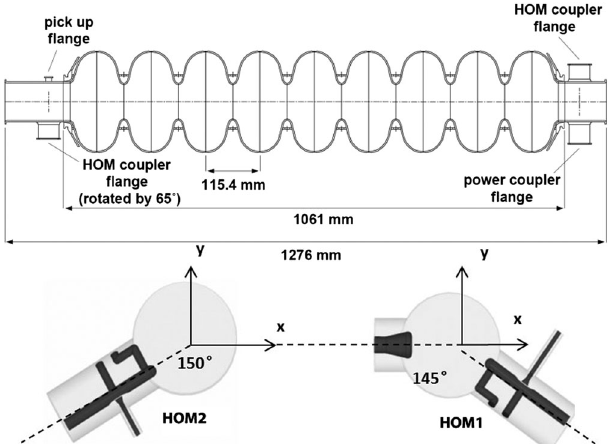
FIG. 2. Drawing of the TESLA cavity with one power coupler, one probe pick up and two HOM couplers. The geometry and orientation of the two HOM couplers are presented in the lower figure. The horizontal ( x ) and vertical ( y ) planes are defined. The HOM coupler close to the power coupler is called HOM1 (downstream in beam direction) and the other